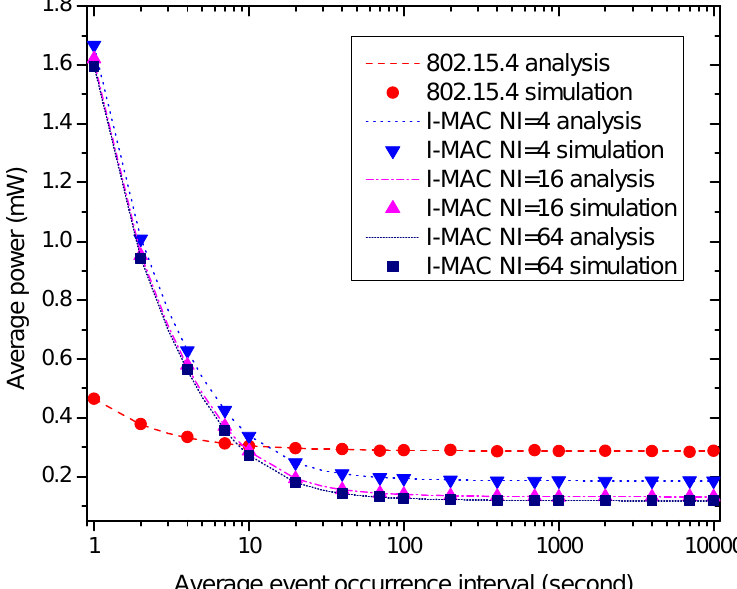
Figure 14. The effect of the average event occurrence interval on the average